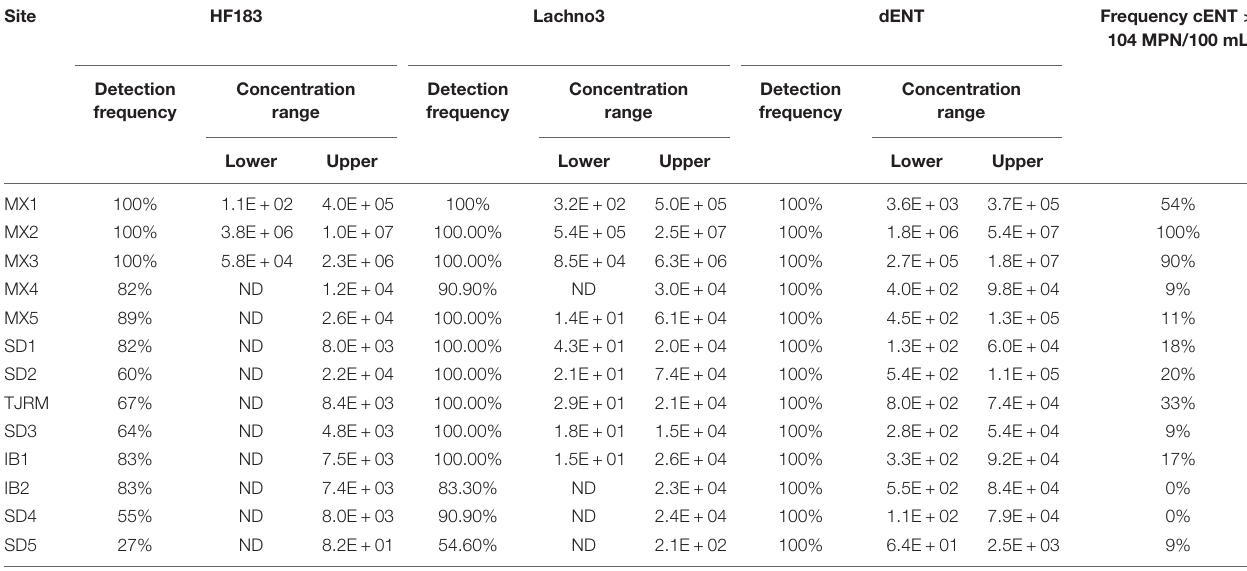
TABLE 2 | Frequency of marker detection and concentration range detected for each marker by site. Site